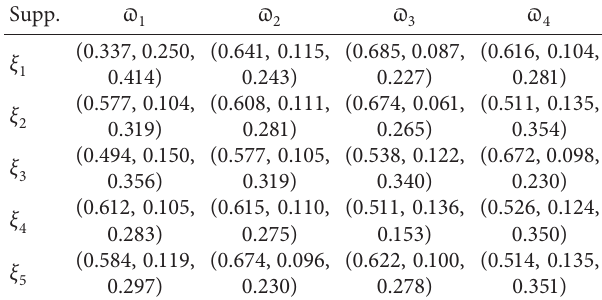
Table 25: Aggregated intuitionistic fuzzy decision matrix.